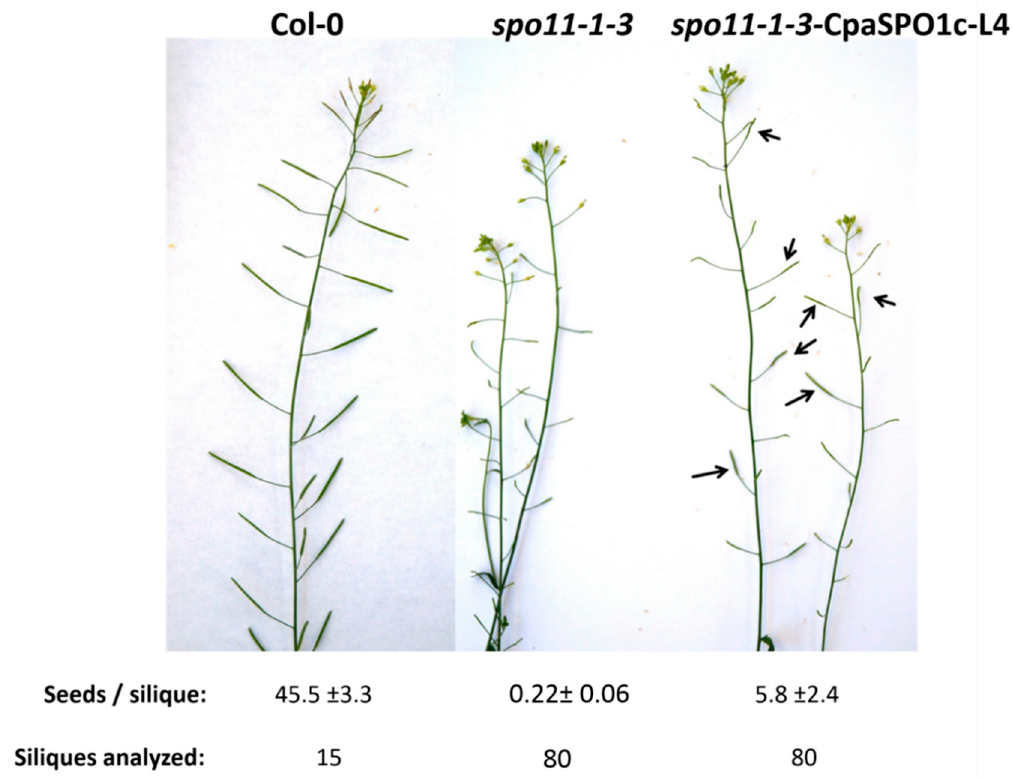
Figure 8. Comparison of wild-type Col-0 with homozygous spo11-1-3 and spo11-1-3-CpaSPO1c Line 4 inflorescence. Enlarged siliques with intact seeds in the complemented line are marked with an arrow.